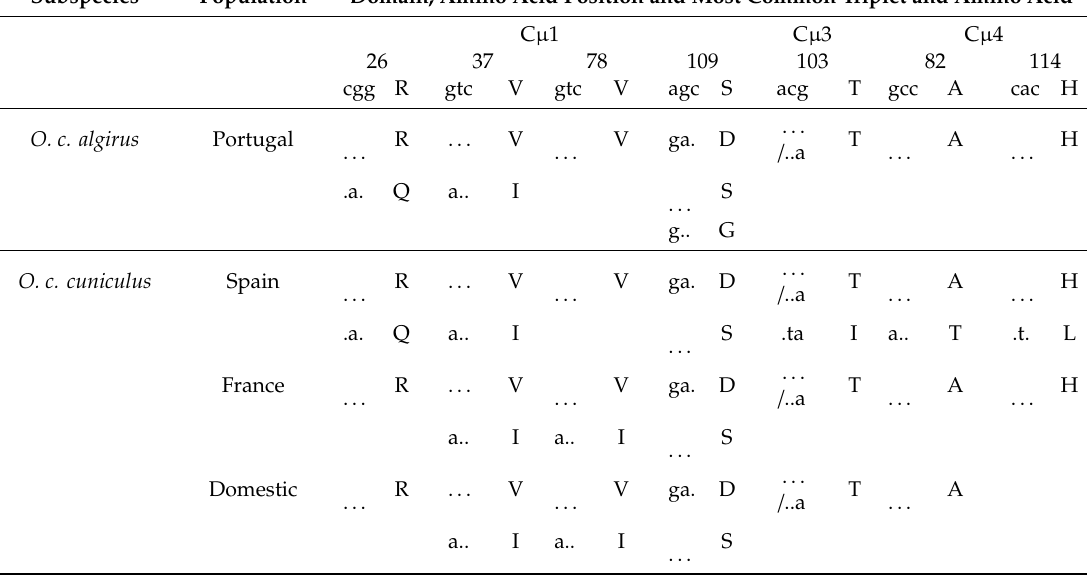
Table 2. IgM amino acid polymorphic positions for European rabbit populations / domestic animals. The nucleotide variation is shown, dots represent identity. The codon numbering is according to the IMGT unique numbering for the constant domain